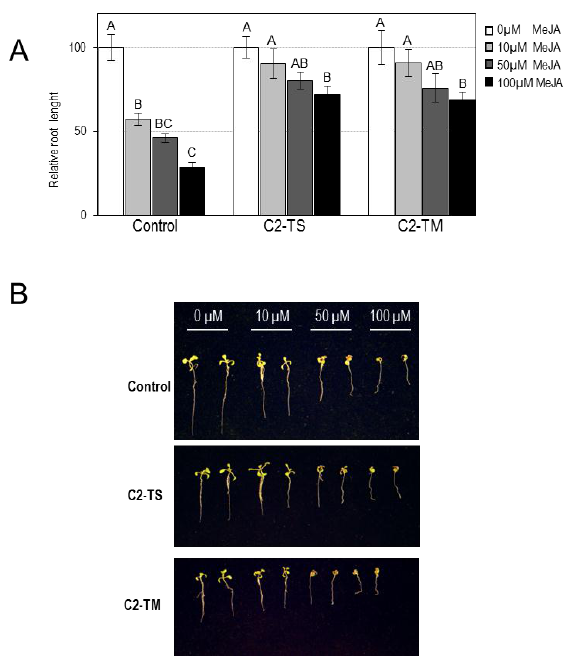
Figure A1. Root growth inhibition assays in C2-expressing plants. ( A ) Relative root length of wild-type Col-0 (Control), C2-TS (plants expressing the C2 gene from TYLCSV), and C2-TM (plants expressing the C2 gene from TYLCV) Arabidopsis seedlings in increasing concentrations of MeJA (0, 10, 50, and 100 μM). The values are the mean of at least ten seedlings. Bars represent standard error. One-way ANOVA Tukey’s Multiple comparison tests were used to distinguish differences among samples at p -value < 0.05. Different letters indicate statistically significant difference. Experiments were repeated three times with similar results; results from one representative experiment are shown; ( B ) Pictures of representative seedlings used in ( A ).